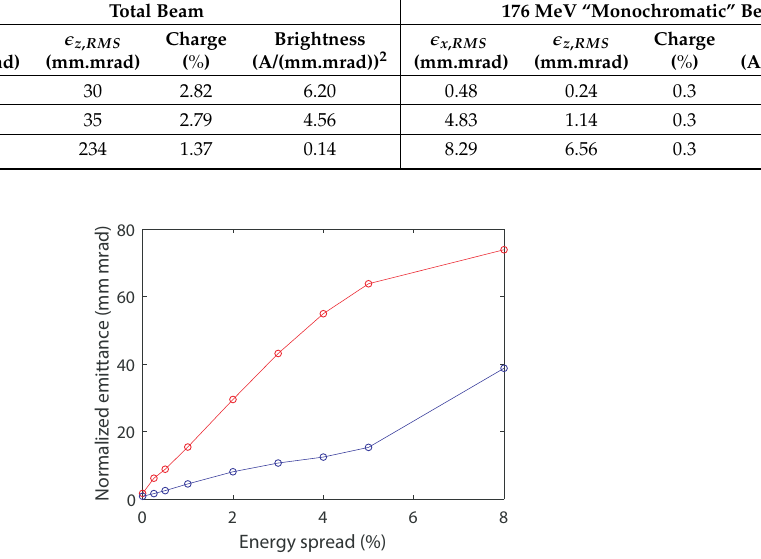
Figure 13. Simulated horizontal ( red ) and vertical ( blue ) normalized emittance of the electron beam at the undulator center for the low a 2 skew terms (Table 2) and the optics “slit-undulator” without slit using flat-top electron beams for different energy spread with 176 MeV central energy, σ (cid:48) = 3.12 mrad, and (cid:101) σ (cid:48) z , i , (cid:101) x , i = 0.2 x , i